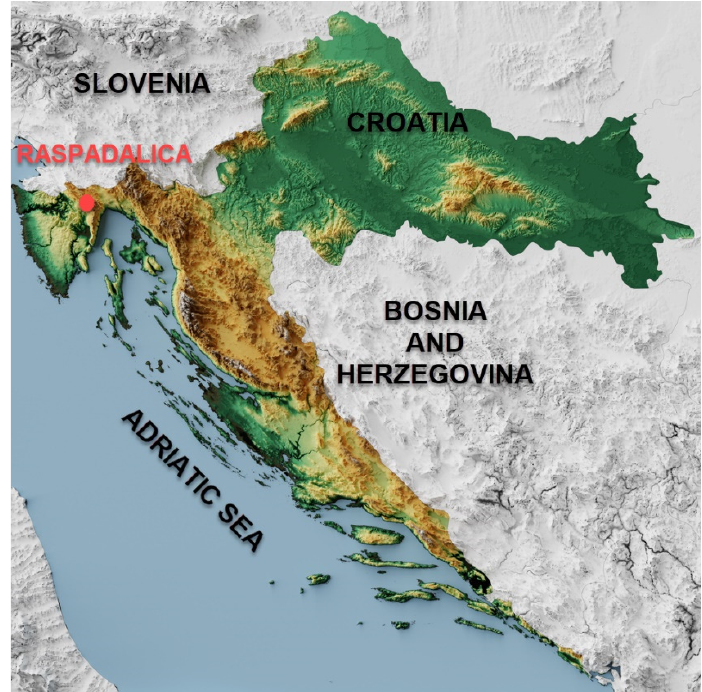
Figure 2. Geographic location of the Raspadalica Cliff.